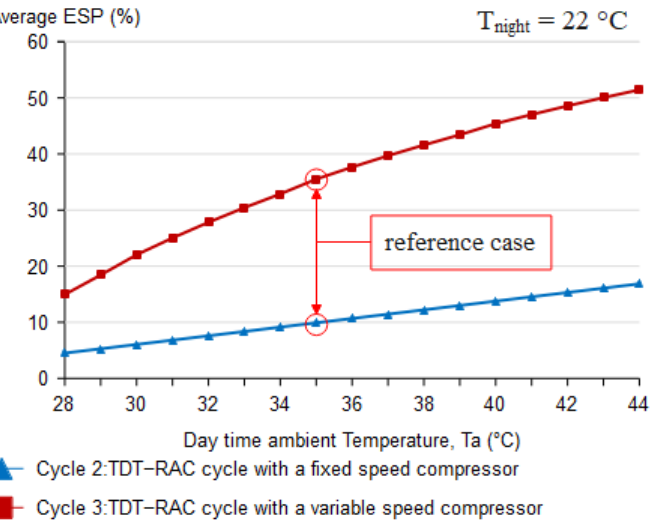
Figure 7. Average ESP versus day time ambient temperature (the minimum night ambient temperature is set as 22 °C).